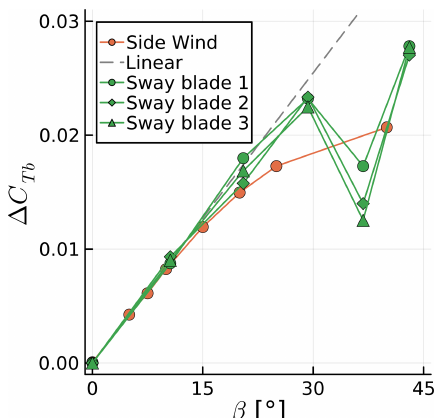
Figure 17. Time history of horizontal sway velocity projected on airfoil chord at the tip of blade 1. Vertical lines show blade azimuth.